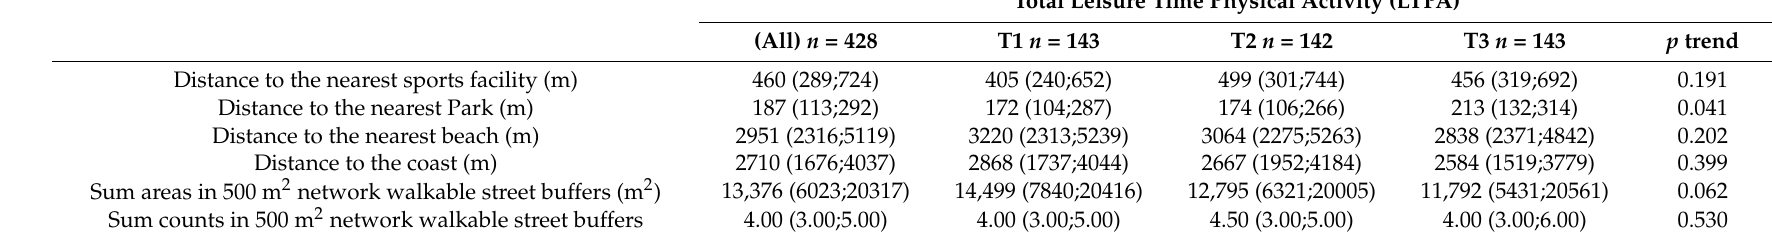
Table 2. Study population POS characteristics according to tertiles of total leisure time physical activity (LTPA). Values shown are n (%) for categorical variables and median (IQR) for continuous variables. Tertile cutoffs are based on total LTPA. The p-value for trend is computed from the Pearson test when row-variable is normal, Spearman test when it is continuous non-normal and Chi-squared test when it is categorical.